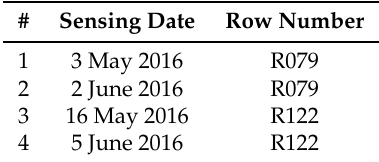
Table 1. Sensing date and row number of Sentinel-2 images used for the detection of alluvial sediments in the study